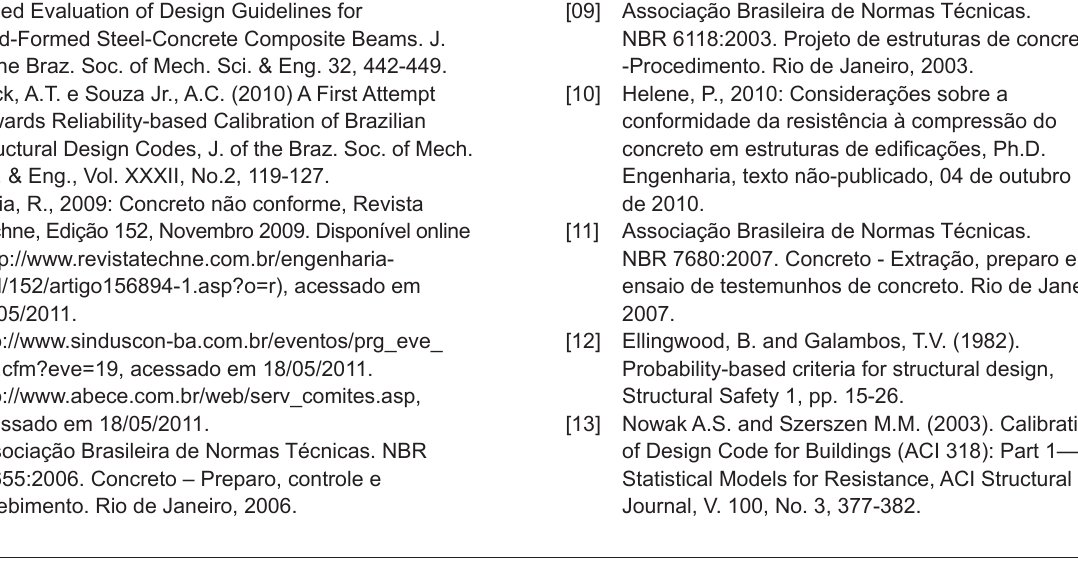
Figure 11 – Sensitivity coefficients for ρ = ρ in terms of load ratio L /D máx n n